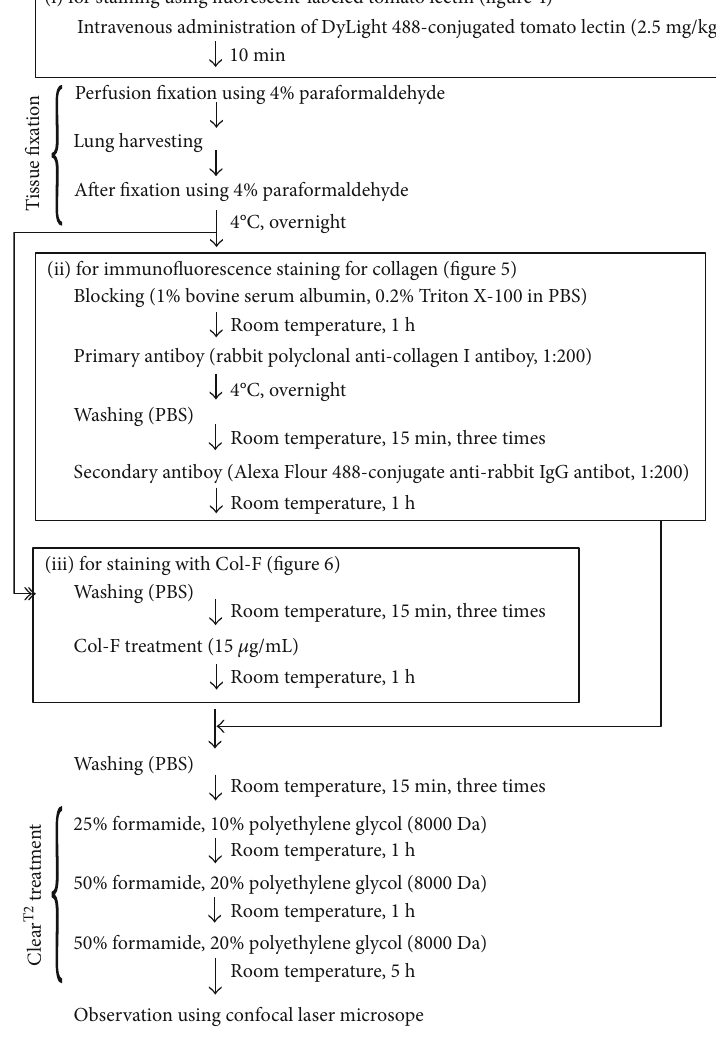
Figure 1: Experimental protocols for extracellular matrix staining and tissue-clearing treatment of fi brotic lungs in mice with bleomycin- induced pulmonary fi